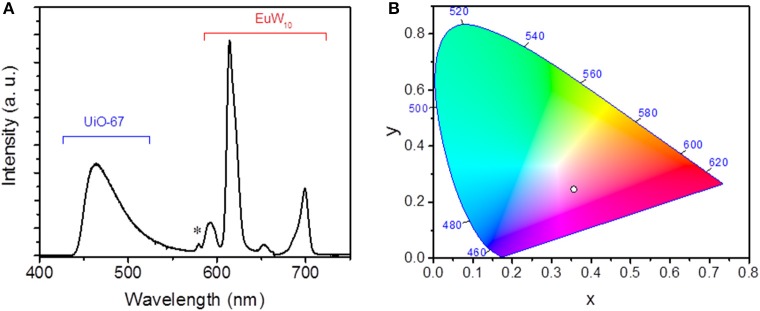
(A) Room-temperature emission spectrum monitored at λexc = 336 nm of EuW10@UiO-67. The asterisk highlights the 5D0→7F0 transition related to the Eu3+ ion; (B) CIE chromaticity diagram for EuW10@UiO-67 excited at 336 nm.